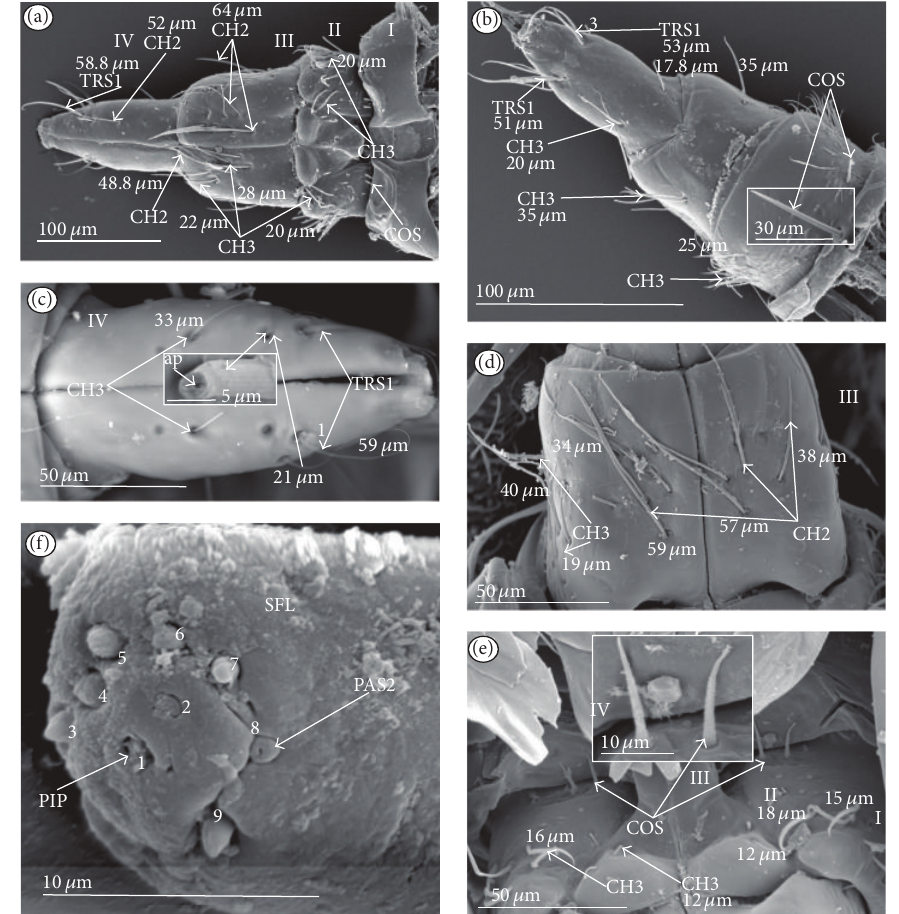
Figure 25: Types and sizes of the sensilla of the Pleidae ( Paraplea frontalis ). (a) CH2 and CH3 are less numerous and spread unevenly over all segment; TRS1 (one) is placed dorsally near the apex; one pair of COS is situated on the II segment. (b) TRS1 (three) are located ventrally near the apex; one pair of CH3 is situated near the proximal edge of the IV segment; one pair of CH3 is situated ventrally on the III segment; several CH3 are visible on the ventral side of the II segment, and some COS are located near the edge of the I segment; no sensila can be seen on segment I (ventral view). (c) TRS1 (one), TRS2 (one), and CH3 (two) are situated on the dorsal surface of the IV segment. (d) CH2 (several) are situated on the dorsal side and CH3 (several) are situated on the lateral side of the III segment. (e) Several CH3 are present on the III segment dorsally as well as one pair of COS. (f) PAS2 (no. 2–9) are placed in a circle on the labial tip, and PIP (no. 1) is situated